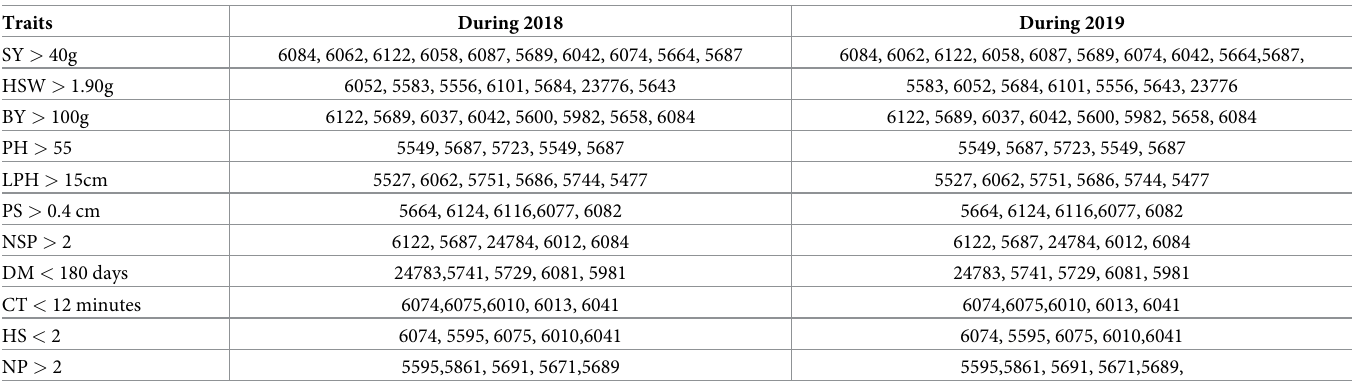
Table 2. List of best performing lentil genotypes selected during both years for quantitative traits. Traits During 2018 During 2019 SY >